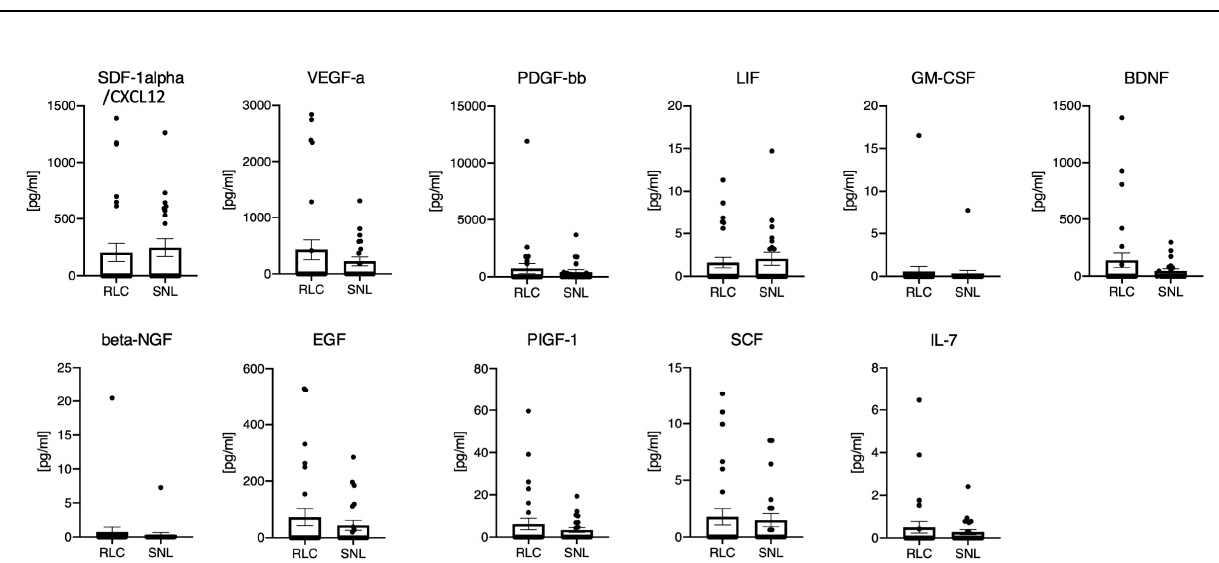
Figure 2. The protein microenvironment of 11 different growth factors in the sera of BA patients does not enable differentiation of clinical outcome. Legend: Multiplex measurement of 11 different growth factors from sera of BA patients with favorable (SNL) or unfavorable course of disease (RLC). For FGF2 and VEGF-D in most samples the levels were below the detection limits of the panel.